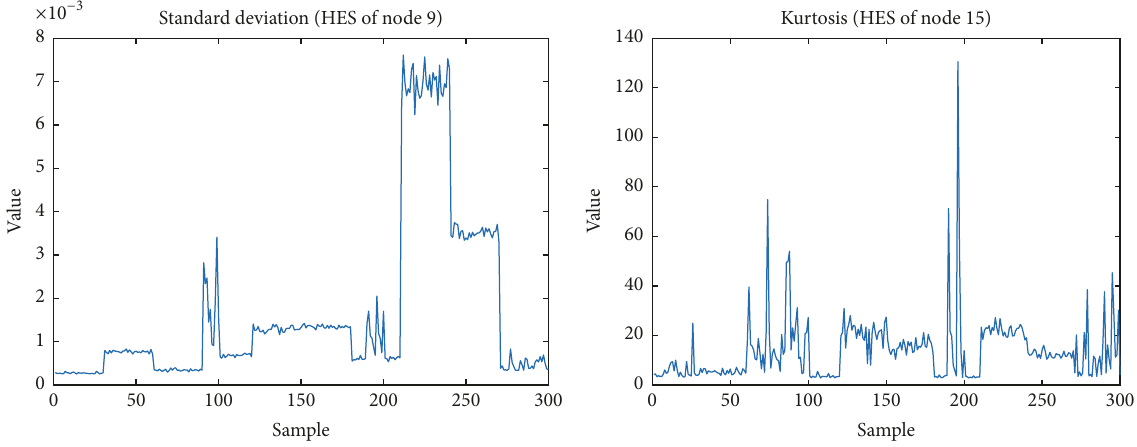
Figure 25: Two HES statistical characteristics of training samples.